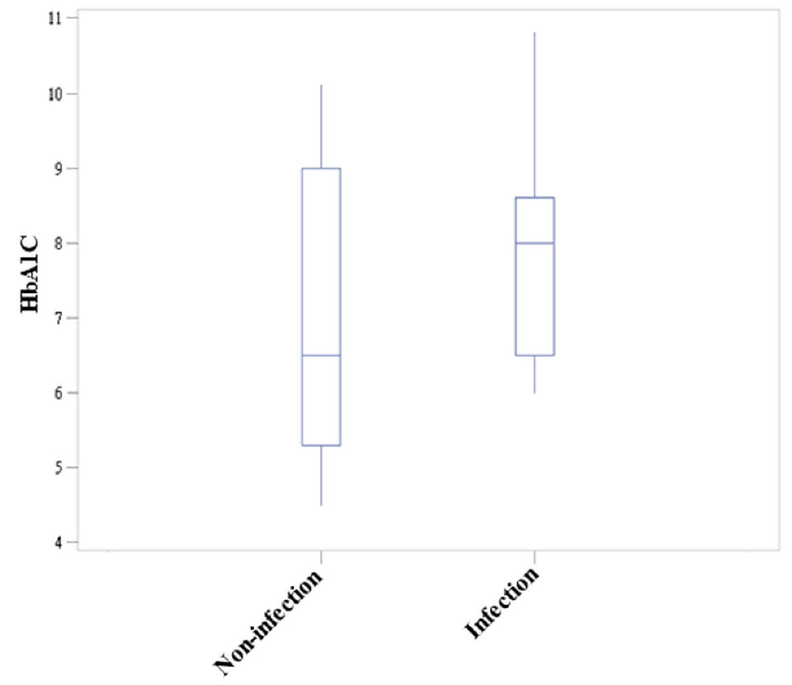
Figure 3. Box–whisker plot revealing the HbA1c level between infection and non ‐ infection